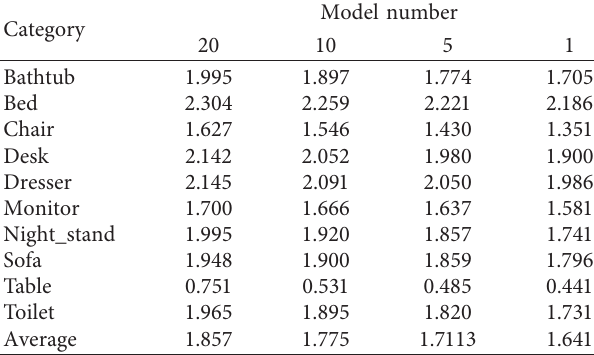
Table 9: The average adjacent view distance.